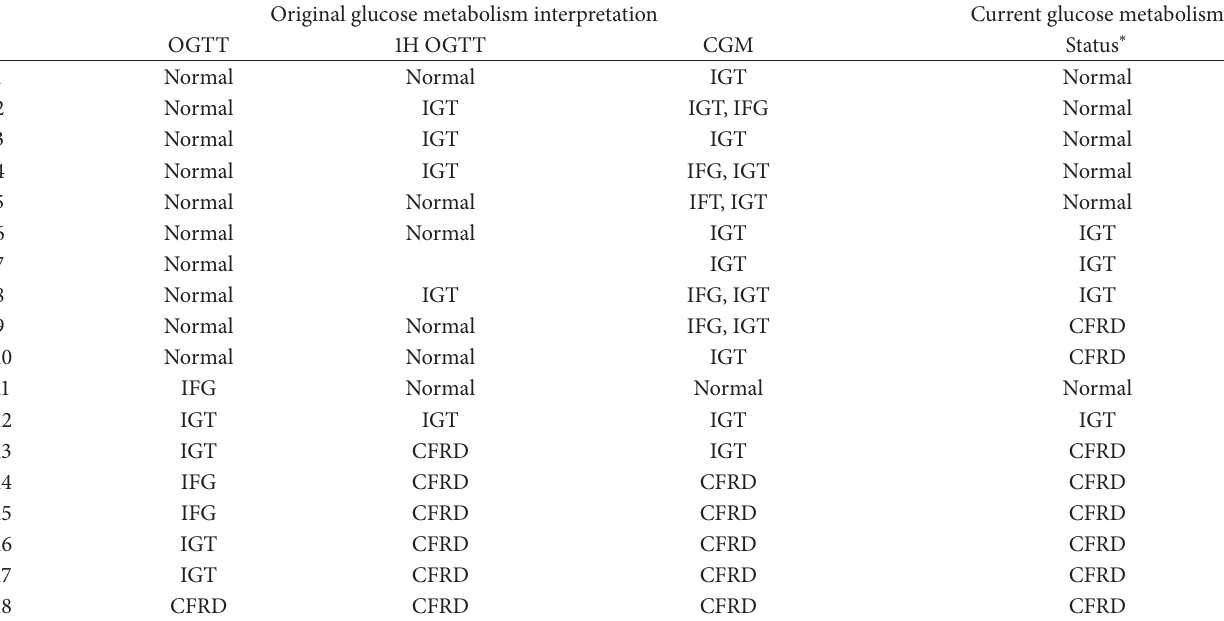
(Table 2), we calculated the sensitivity, specificity, and positive (PPV) and negative predictive values (NPV) for CFRD of subjects’ initial testing (CGM, 1-hour OGTT and 2-hour OGTT results). The sensitivity, specificity, PPV, and NPV